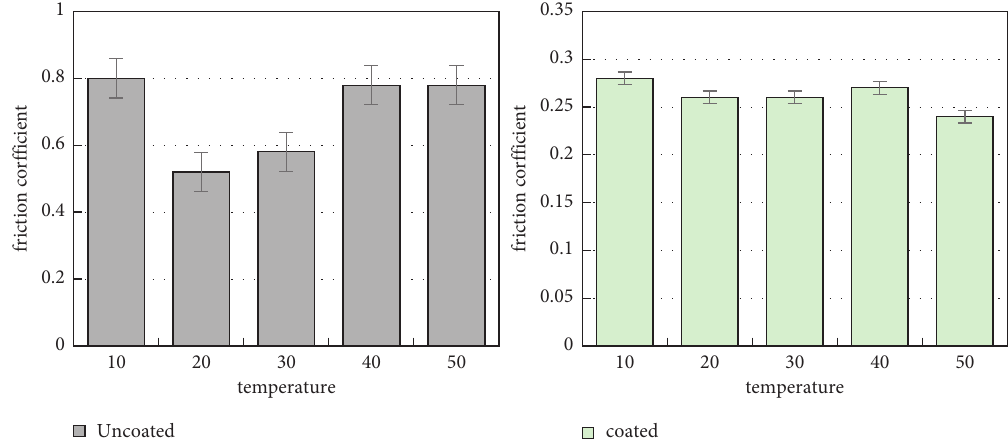
Figure 6: Abrasion resistance of box board base paper and coated box board at different